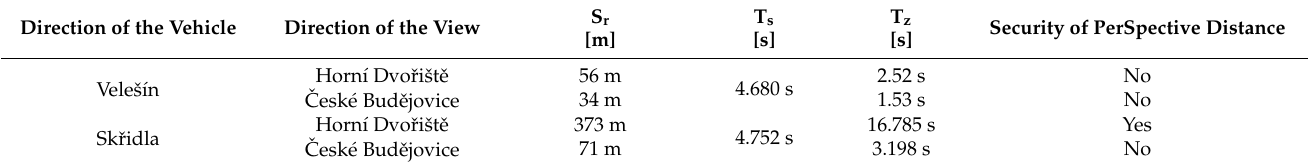
Table 9. Security of perspective ratios for drivers of road vehicles at crossing